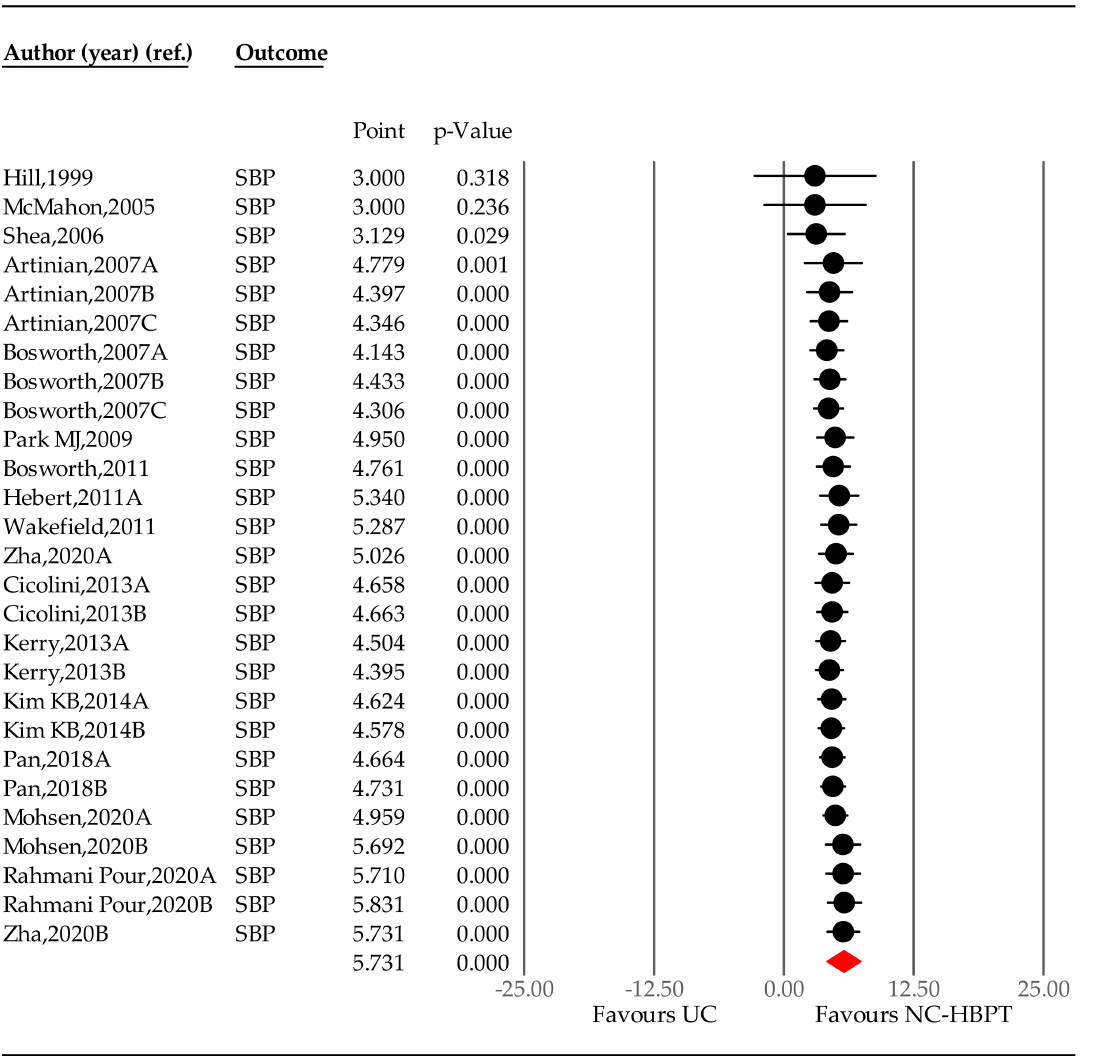
Figure A1. Cumulative meta-analysis presenting the summative effect at each time point. Note. SBP, systolic blood pressure; Figure 6. Difference in means of office systolic blood pressure changes over time. Notes. Point estimate of individual study UC, usual care; NC-HBPT, nurse-coordinated home blood pressure telemonitoring; Summary effect size ( ( ● ); Subgroup ( ○ ); Summary effect size ( ◆ ); DBP, diastolic blood pressure; UC, usual care; NC-HBPT, nurse-coordinated home blood pressure